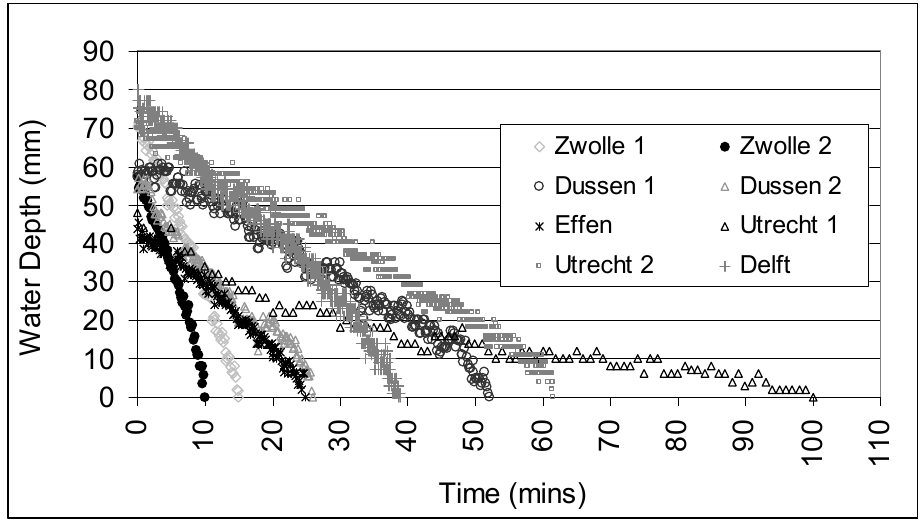
Figure 7. Infiltration curve results for the eight permeable pavements tested in the study.